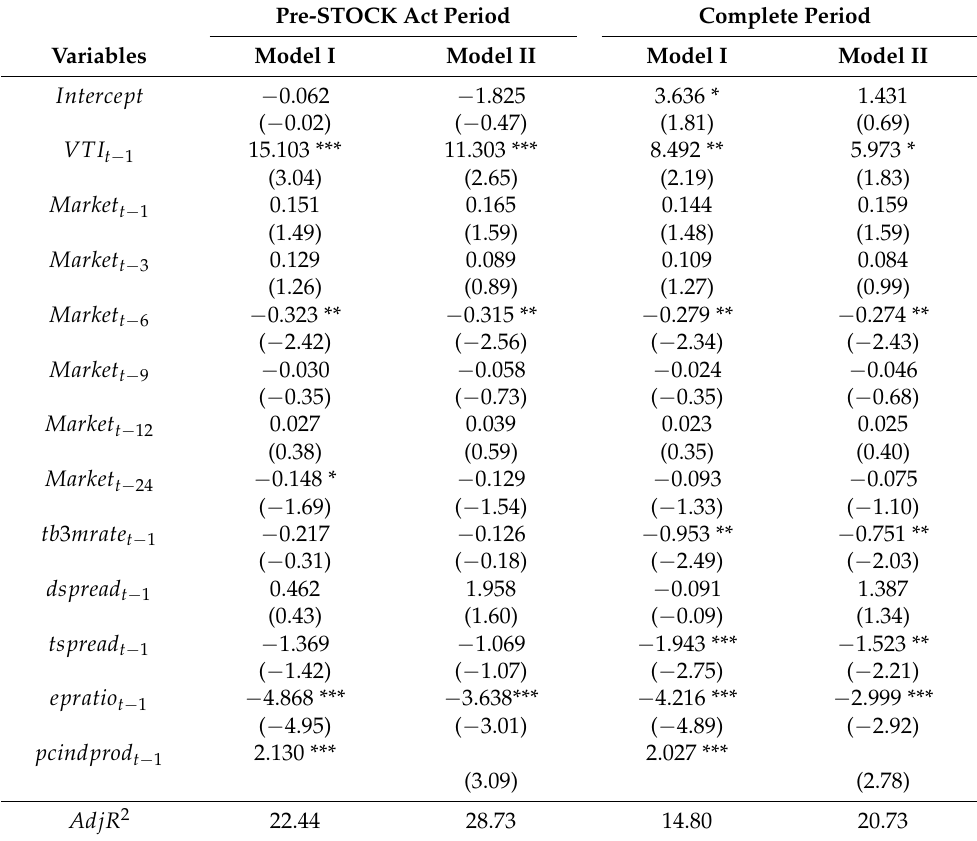
Table 4. Volume-based trading index and equal-weighted market